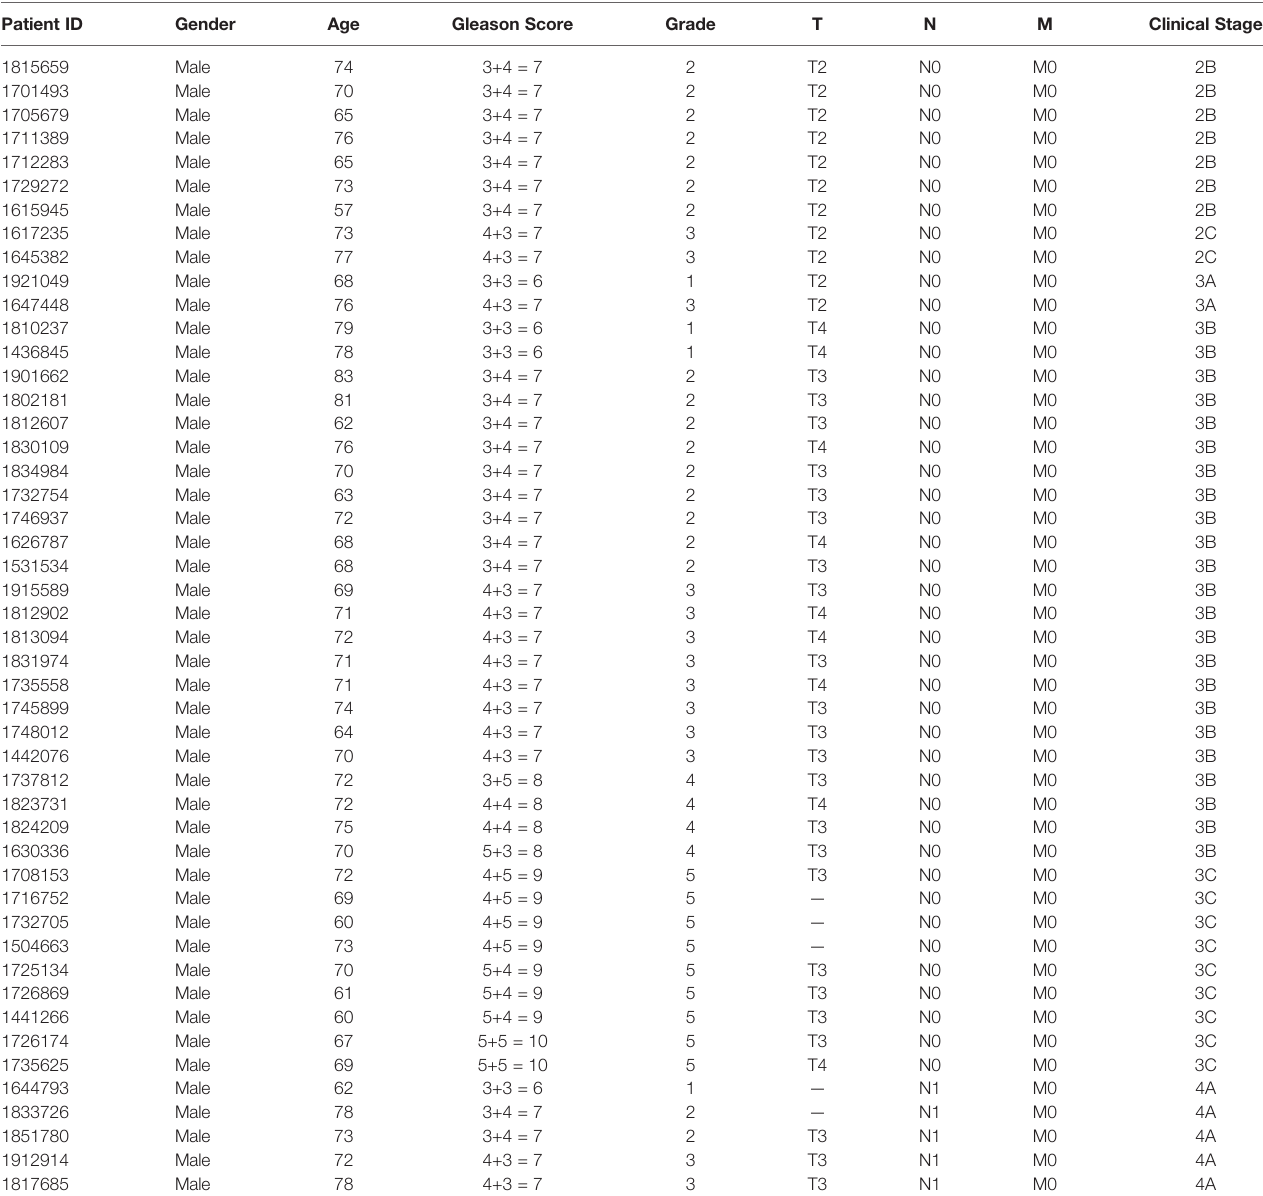
TABLE 1 | Detailed information of the 48